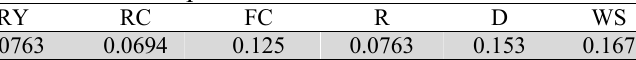
Criteria weights for high speed naval craft material selection problem Criteria YS YM FR RY RC Weight